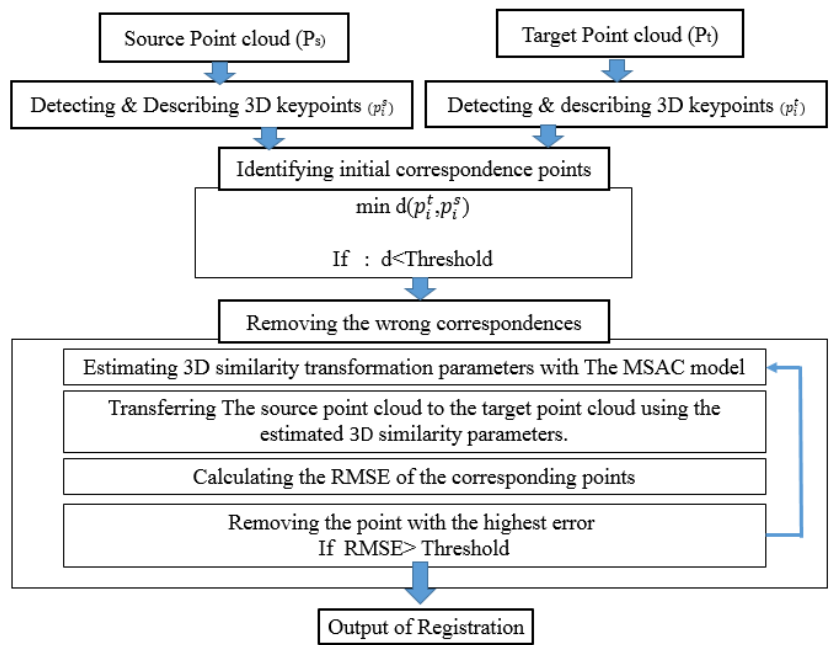
Figure 7. A diagram of the steps of matching and registration.